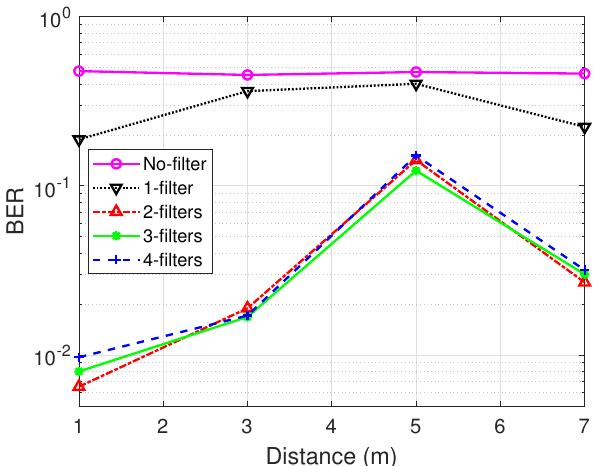
Figure 11. Bit-error-rate comparison of no filter, filter and multi-filter.